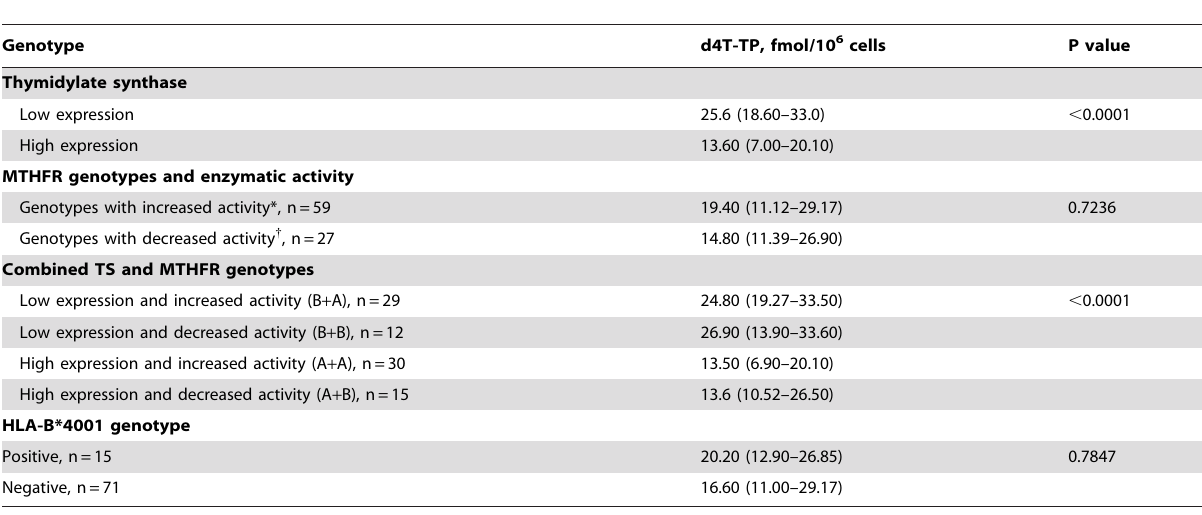
Table 5. d4T-TP intracellular levels according to TS and MTHFR genotypes, and HLA B*-40:01